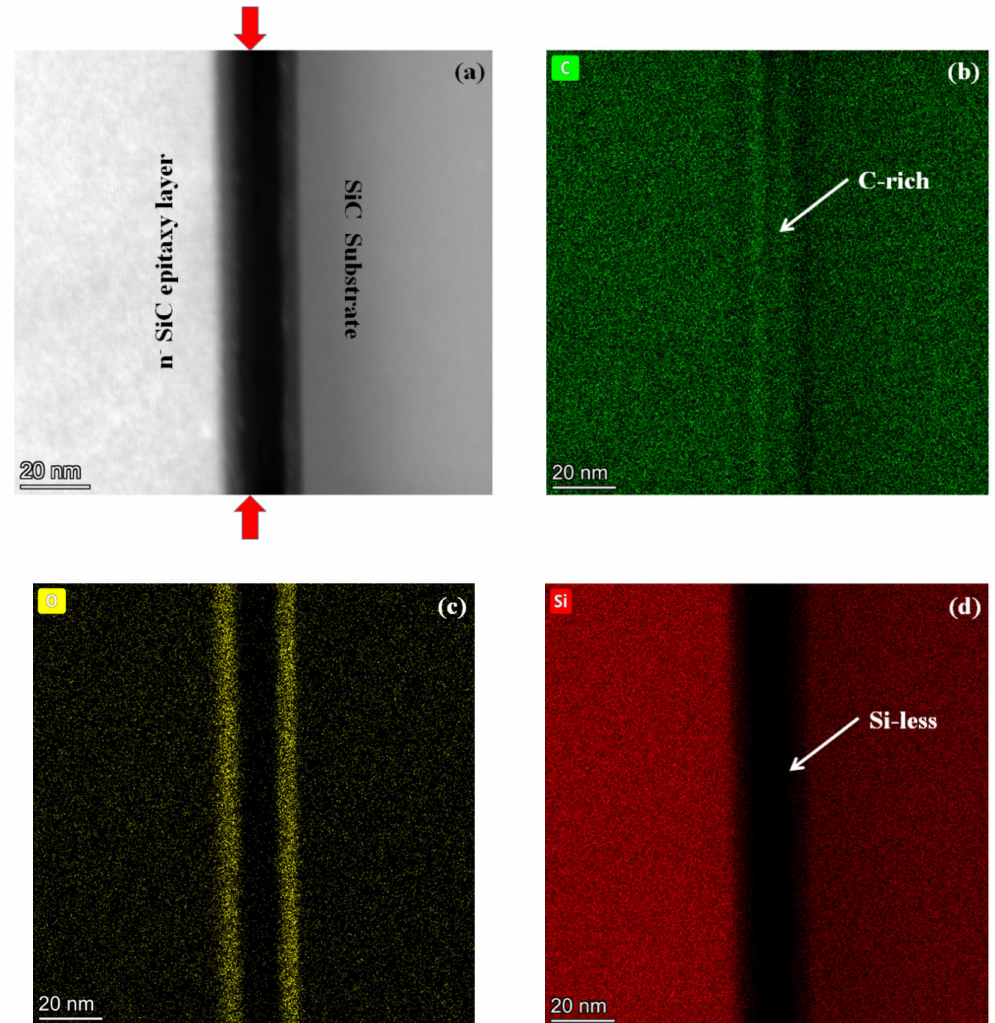
Figure 10. EDX element (C, O and Si) mapping of the bonding interfaces: ( a ) Mapping position at bonding interface; ( b ) C mapping; ( c ) O mapping; ( d ) Si